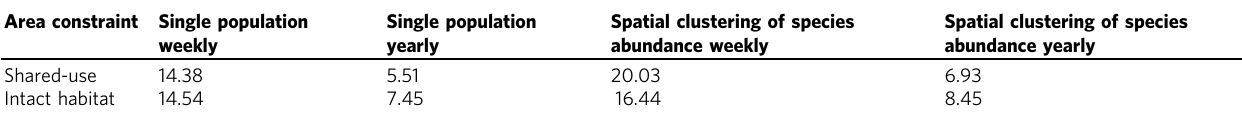
Table 1 Area requirements to meet a 30% population